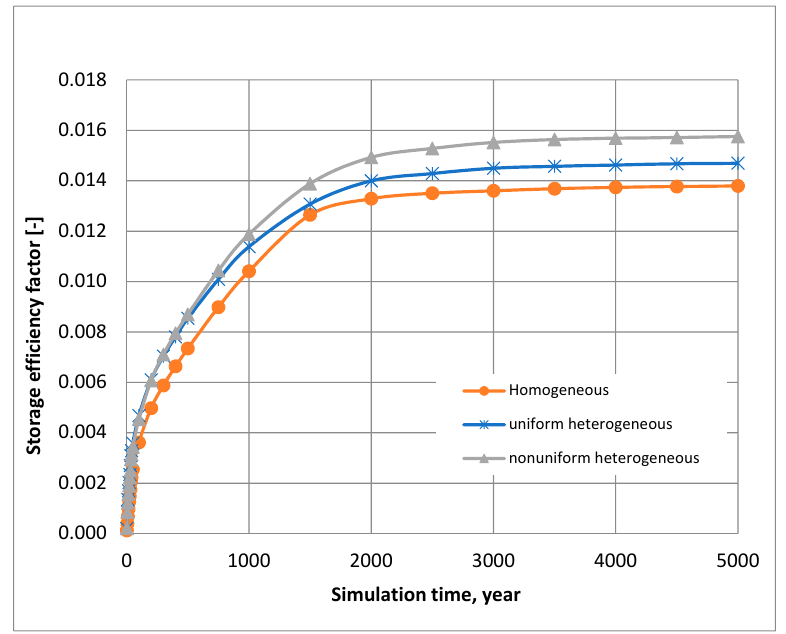
ffi ciency factor for Cases 1, 2 and 3 (Table Figure 6. Influence of heterogeneity on storage efficiency factor for Cases 1, 2 and 3 (Table 3). Figure 6. Influence of heterogeneity on storage e